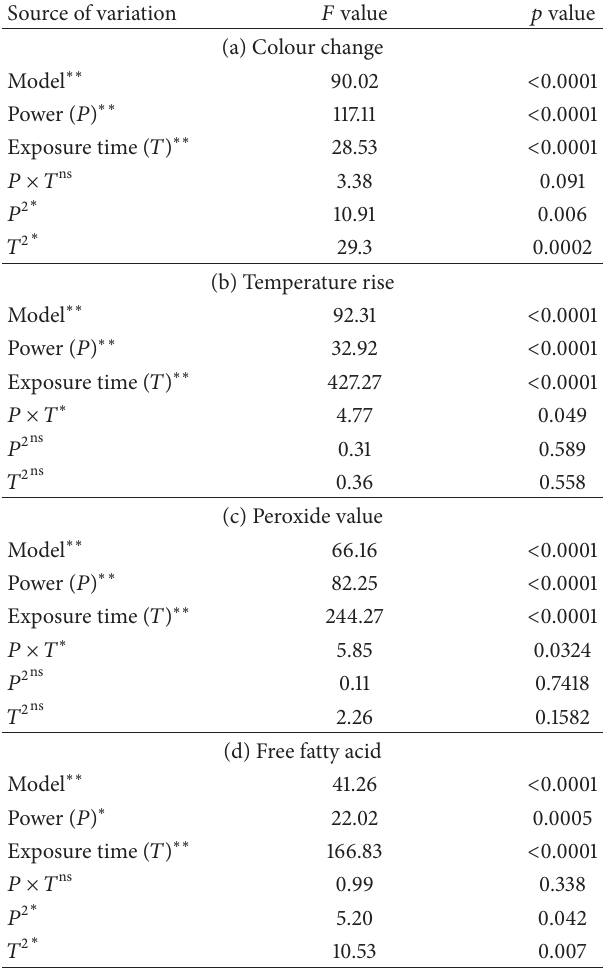
Table 3: ANOVA for different quality attributes of microwave treated cashew